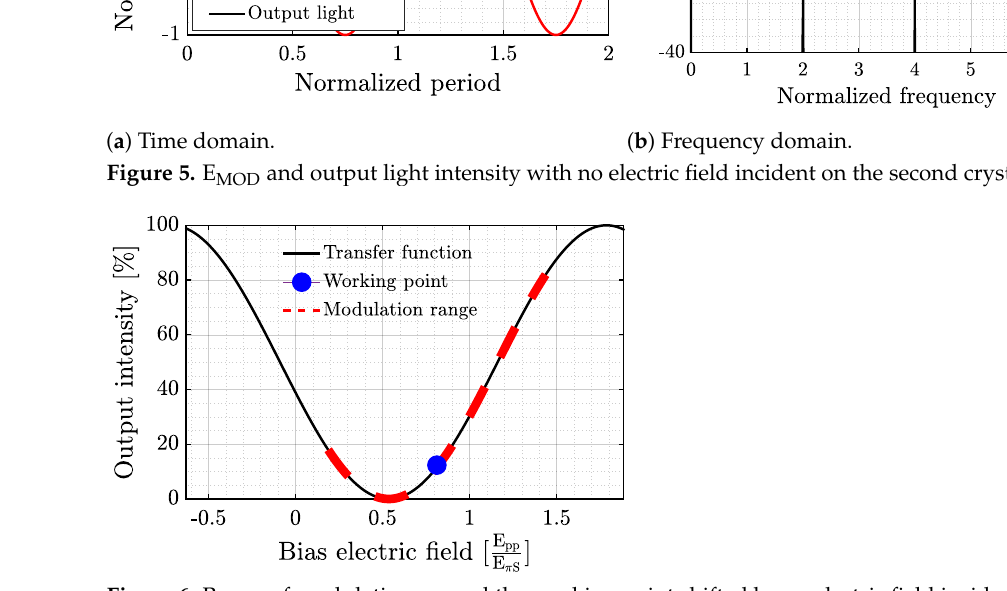
Figure 6. Range of modulation around the working point shifted by an electric field incident on the second crystal.